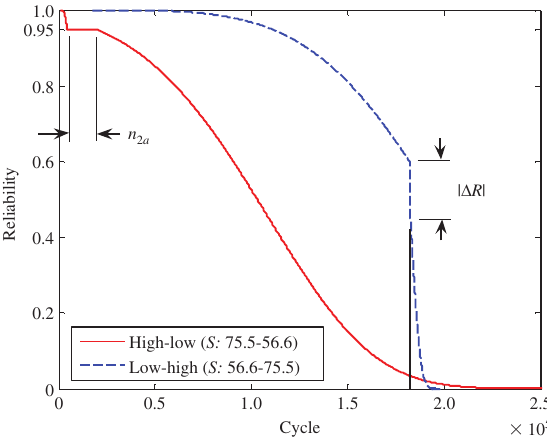
Figure 3 Typical expression of reliability degradation with the transition period and reliability drop under a high-low and a low- high fatigue loading, respectively.